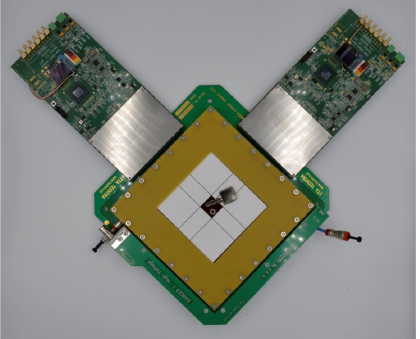
Figure 7. The Measurement setup—GEM detector with two Techtra 256ch electronic Readout V2.0 boards and metal samples placed on the active area of the